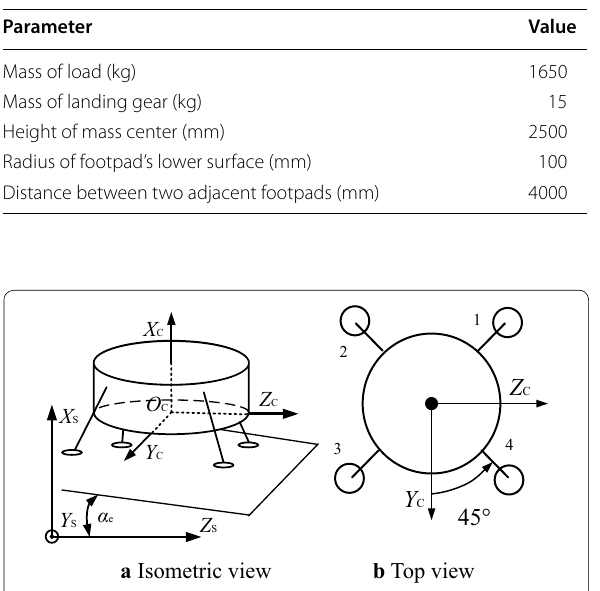
Figure 4 Definition of coordinate systems